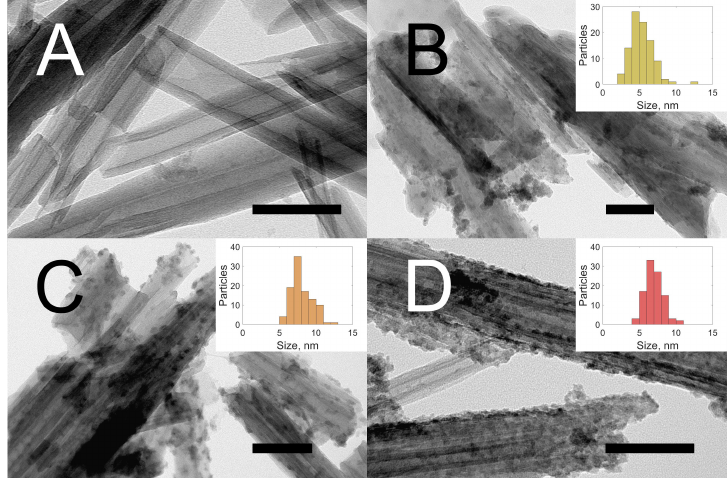
Figure 1. TEM images of pristine HNT ( A ); HNT-NH 2 -CdS ( B ); HNT-Azine-CdS ( C ); and HNT-Azine- Cd 0.7 Zn 0.3 S ( D ). Particle size distributions derived from measurements of 100 particles for each sample are shown in insets ( B – D ), (see also Table S1 in Supplementary